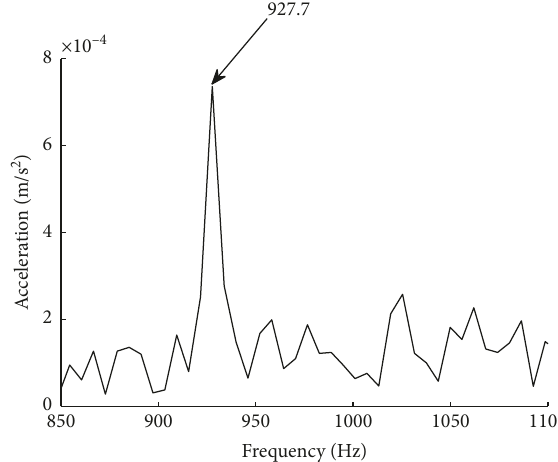
Figure 10: The acceleration-response spectrum corresponding to effective tension (cid:31)